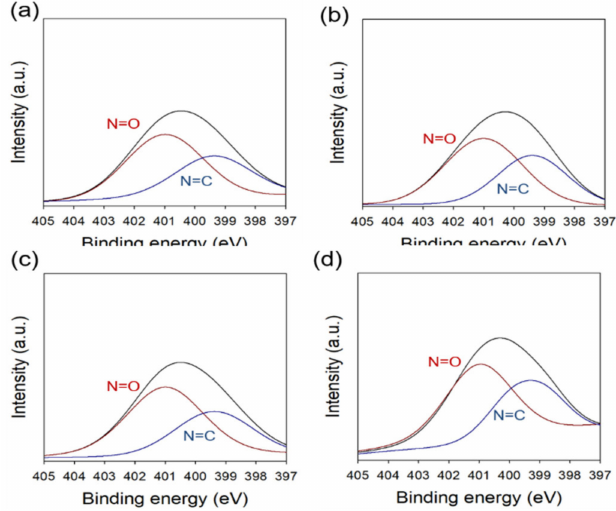
Figure 7. XPS spectra (N1s) of MD / PAA hydrogel film with di ff erent MD content: ( a ) 0.1 wt%, ( b ) 0.25 wt%, ( c ) 0.5 wt%, and ( d ) 1